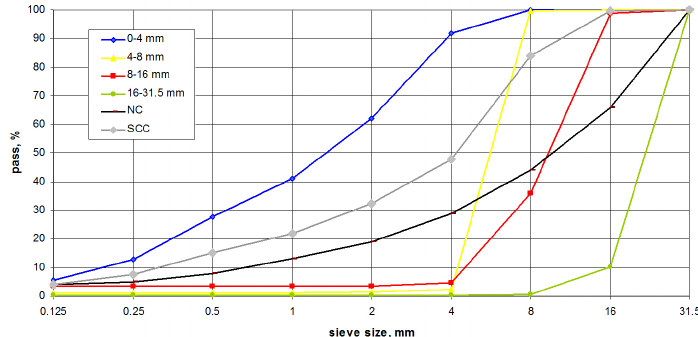
Figure 2. Composition and grain size distribution (Granulometric curve) of the crushed limestone